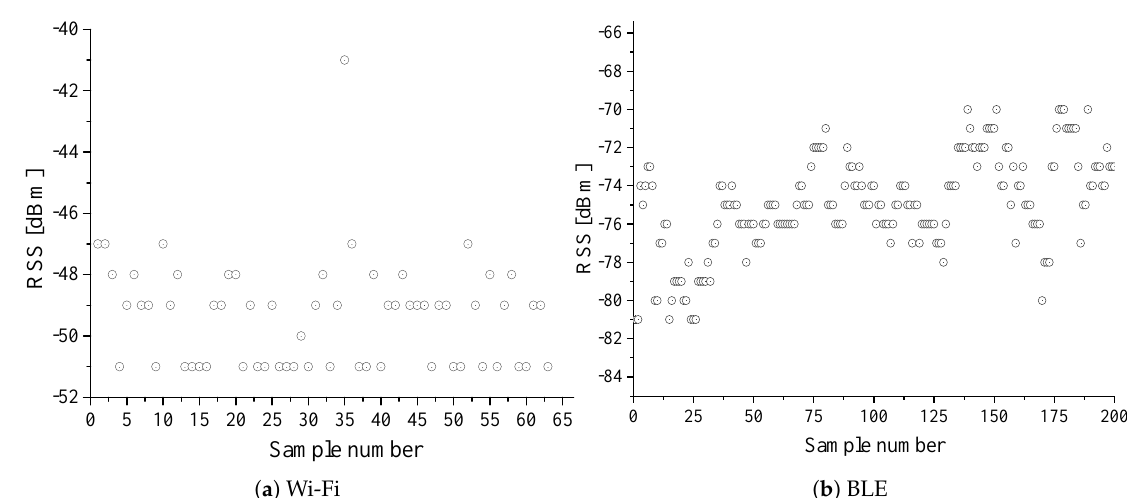
Figure 7. Variation of Wi-Fi and BLE RSS at a fixed indoor